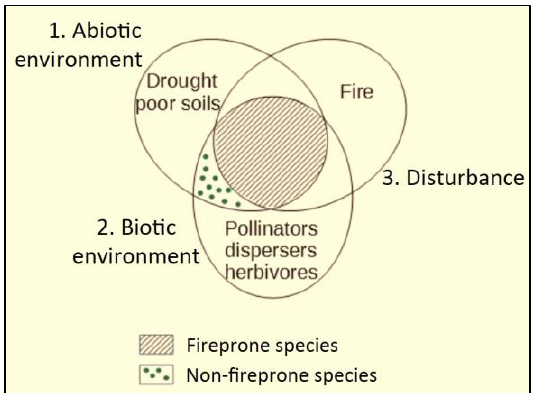
Figure 1. Venn diagram showing how the three dimensions of environmental constraints interact to control the ecology and evolution of the Earth’s terrestrial biota, with non-fireprone species limited in abundance by comparison. Examples of possible constraints have been added to the zone of influence of each dimension. Adapted from Pausas and Lamont